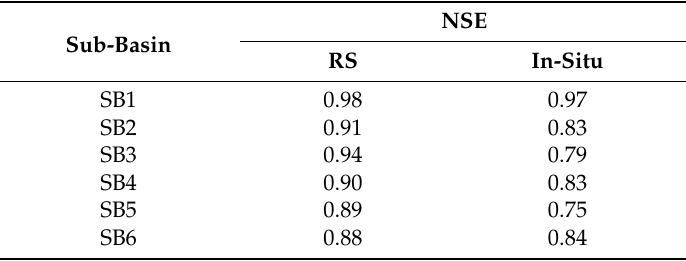
Figure 7. The LMRB model verification. Scatterplot of monthly observed and simulated discharge in m 3 /s for the Lower Mekong River at six sub-basin watersheds in validation of the LMRB model for 2001–2004, and 2007. Black circles indicate simulated discharge with satellite-based remote sensing meteorological data input, while red rectangles indicate simulated discharge with in-situ precipitation and air temperature data input. performance metrics are depicted for each sub-basin corresponding to satellite-based remote sensing (RS) and in-situ data input, respectively.